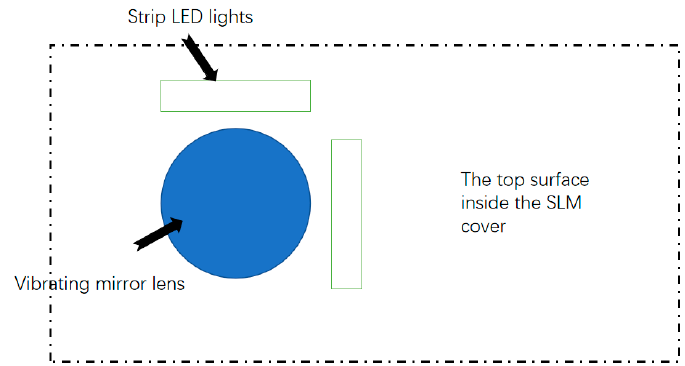
Figure 2. Light-Emitting Diode (LED) light installation position.